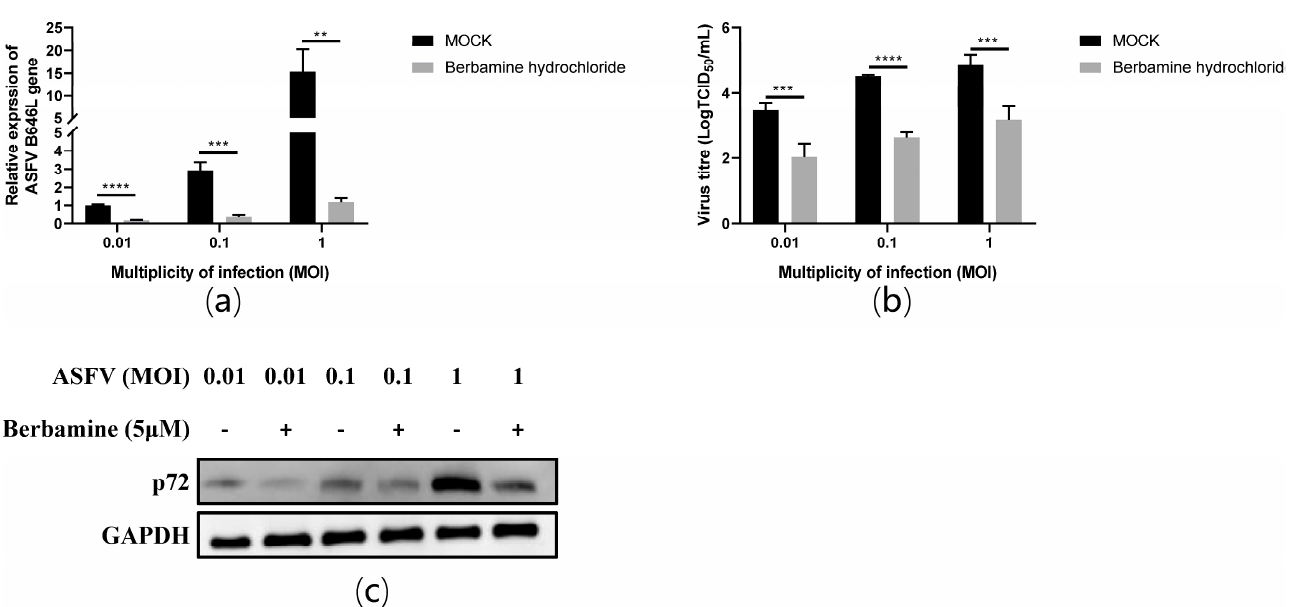
Figure 4. The antiviral activity of berbamine hydrochloride against the ASFV at different MOI (MOI = 0.01, 0.1, and 1) in PAMs. ( a ) The ASFV B646L transcription level was evaluated with an RT-qPCR; ( b ) the ASFV production was evaluated with a TCID 50 assay; ( c ) the ASFV p72 protein expression level was evaluated with Western blotting. Each datum represents the results of three in- dependent experiments (means ± SD). Significant differences compared with the control group are denoted with **, p < 0.01; ***, p < 0.001; ****, p <